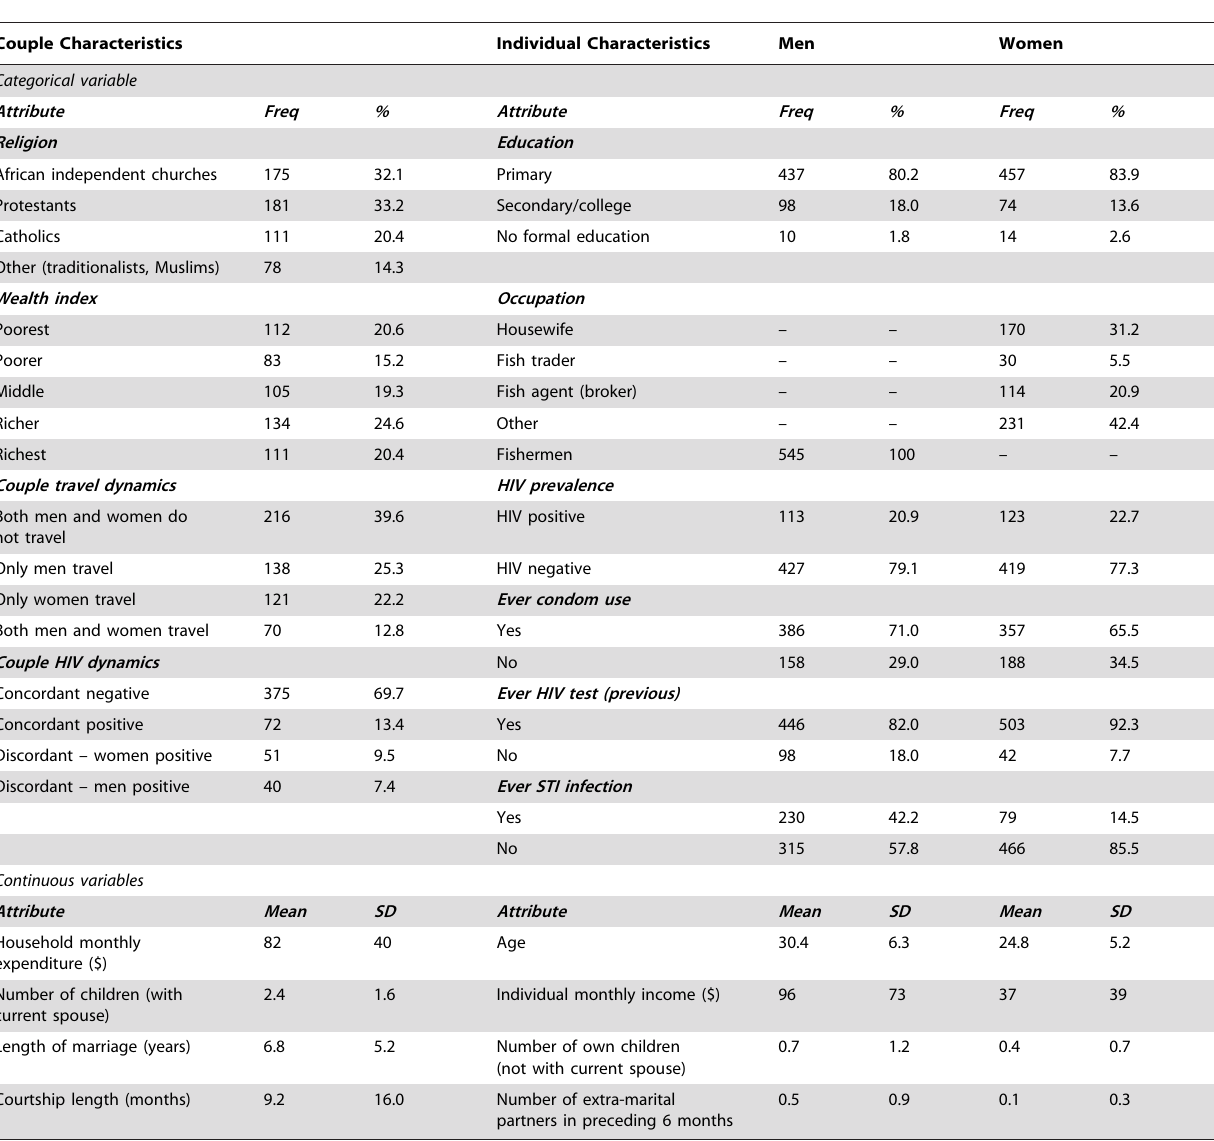
Table 1. Socio-economic and demographic characteristics of the fishermen and their spouses.